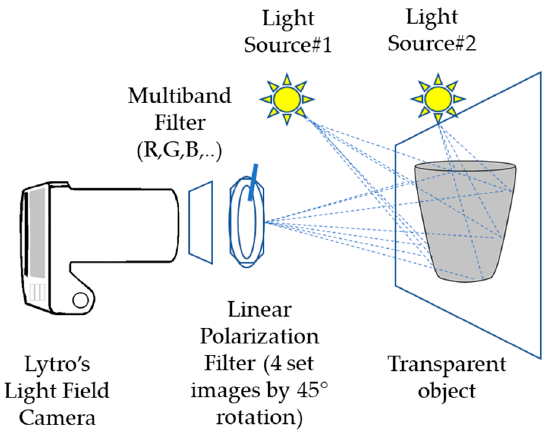
Figure 1. Schematic diagram of the proposed image acquisition in multispectral polarimetric light field imagery (MSPLFI).